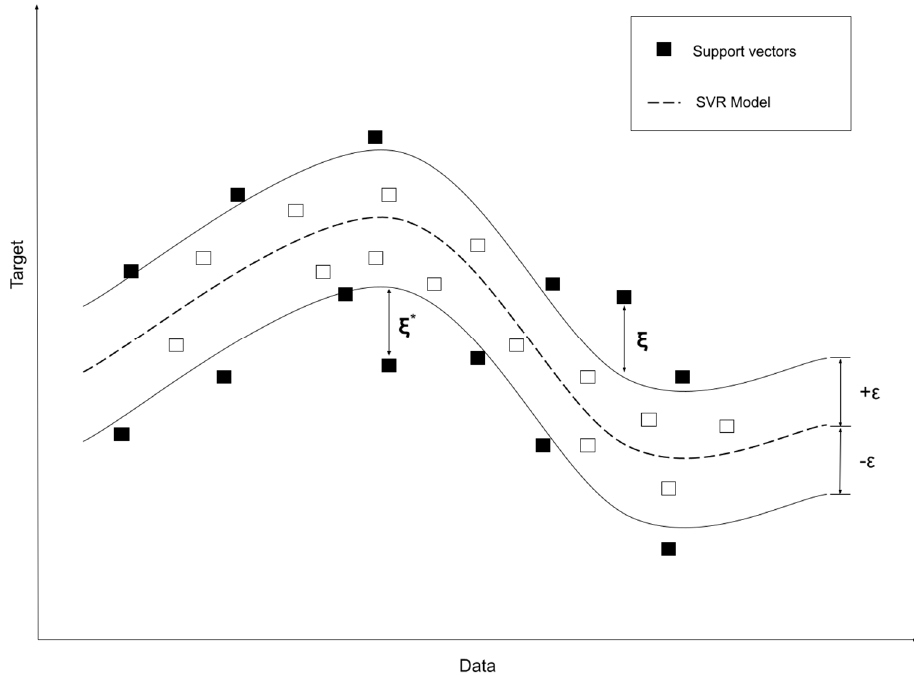
Figure 7. Non-linear SVR, adapted from [29].